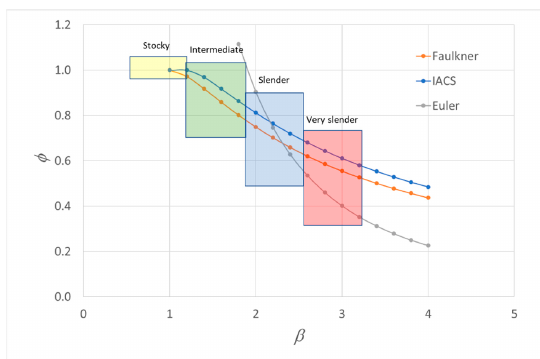
Figure 4. Strength of rectangular plates according to Faulkner, IACS and Euler